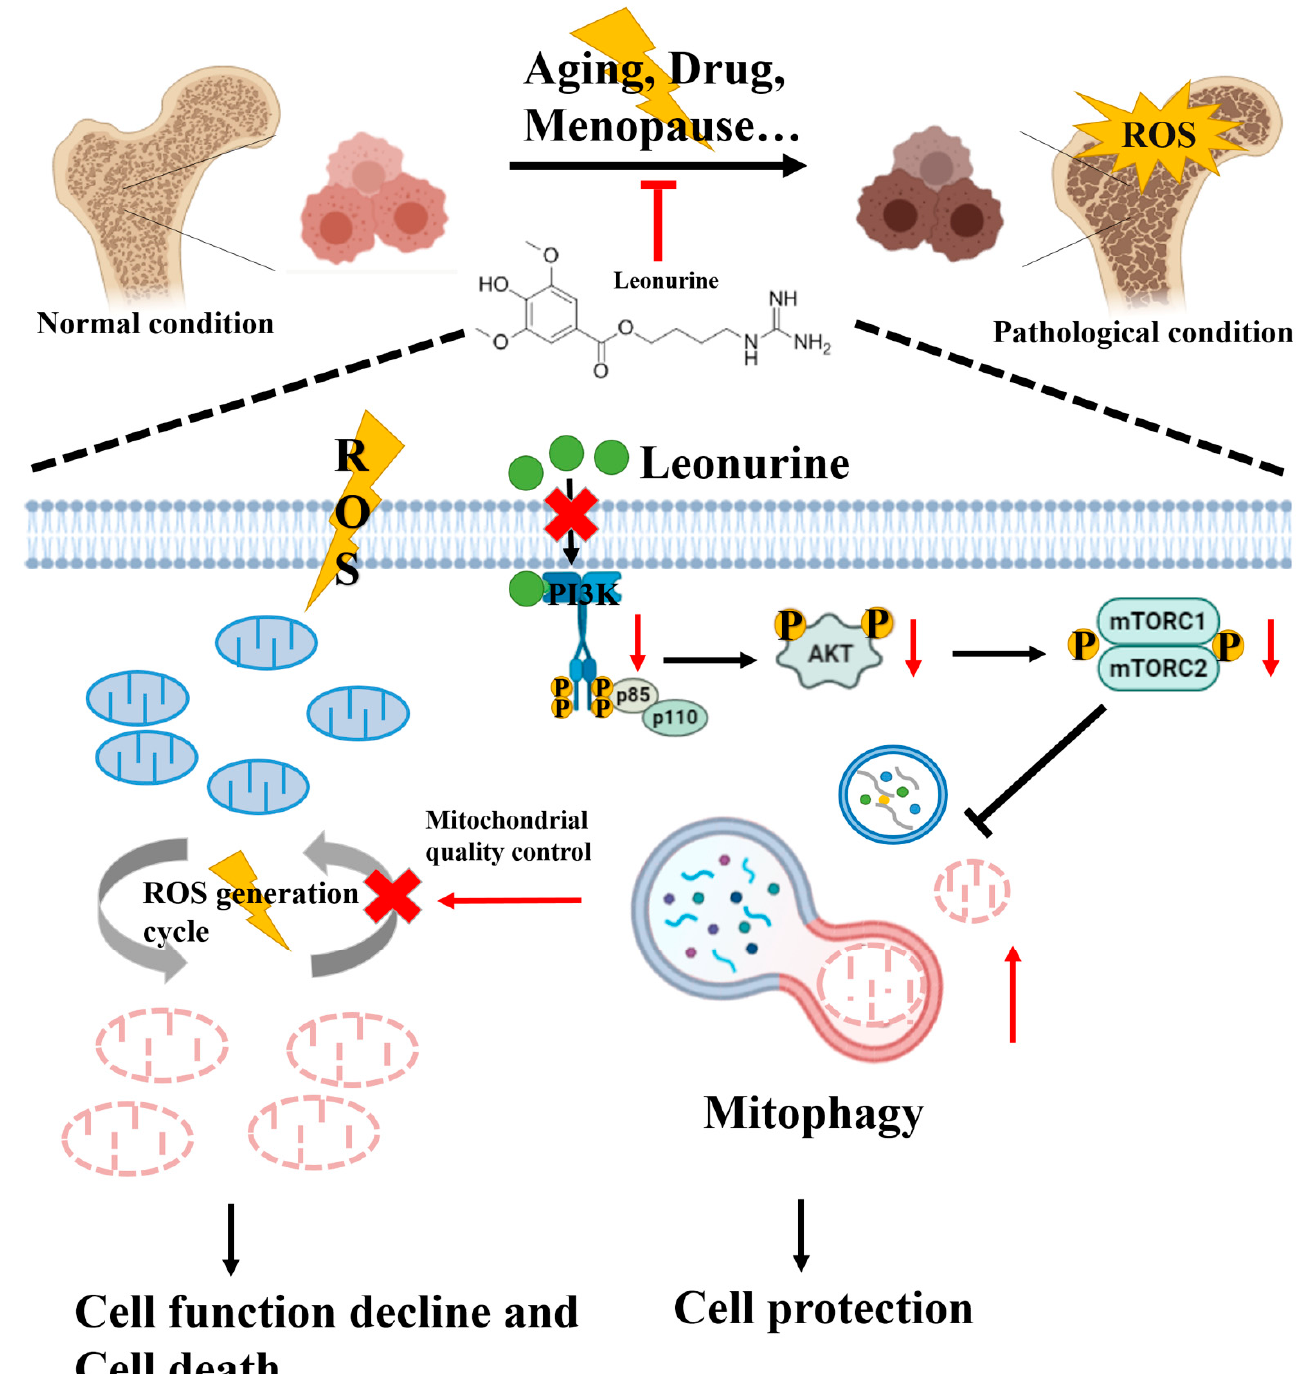
Figure 8. Mechanisms underlying our results. Leonurine ameliorates ROS damage to BMSCs by blocking ROS generation cycle by mitophagy to keep mitochondrial quality control. The mechanism probably involves the moderate activation of the PI3K-AKT-mTOR pathway. Therefore, leonurine can activate mitophagy to alleviate damage to BMSCs form ROS overload by the moderate PI3K- AKT-mTOR pathway.